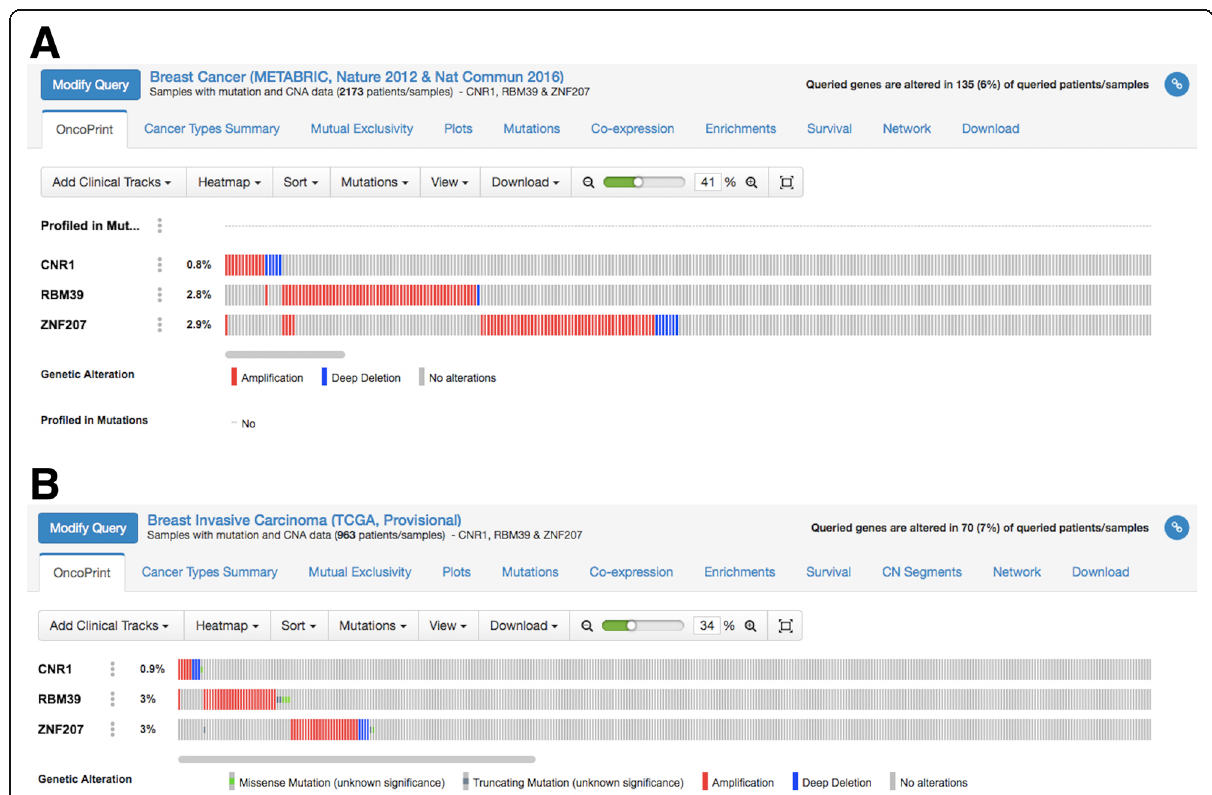
Fig. 4 Summary of alterations in CNR1, RBM39, and ZNF207 across breast cancer patients using a study from a METABRIC and b TCGA provisional, as analyzed by